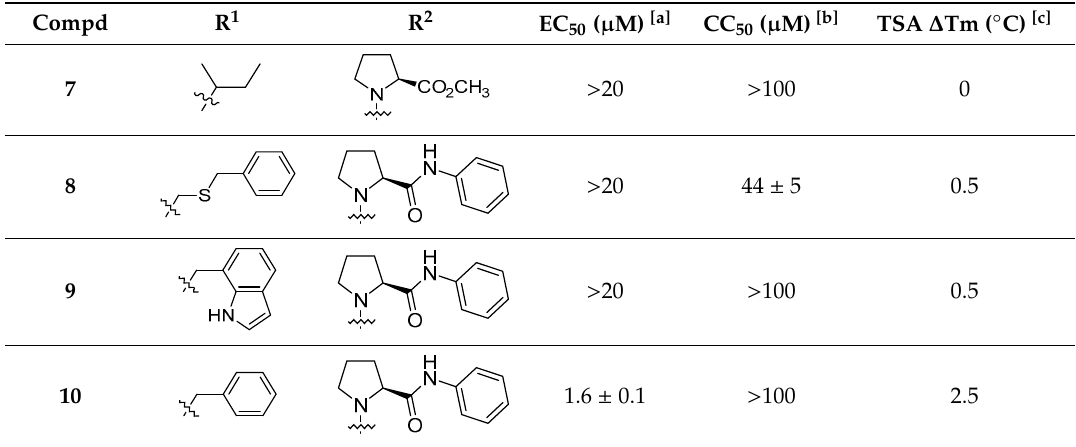
a Concentration of compound inhibiting HIV-1 replication by 50%, expressed as the mean ± standard deviation from at least two independent experiments. b Concentration of compound causing 50% cell death, expressed as the mean ± standard deviation from at least two independent experiments. c TSA: compound minus DMSO control.